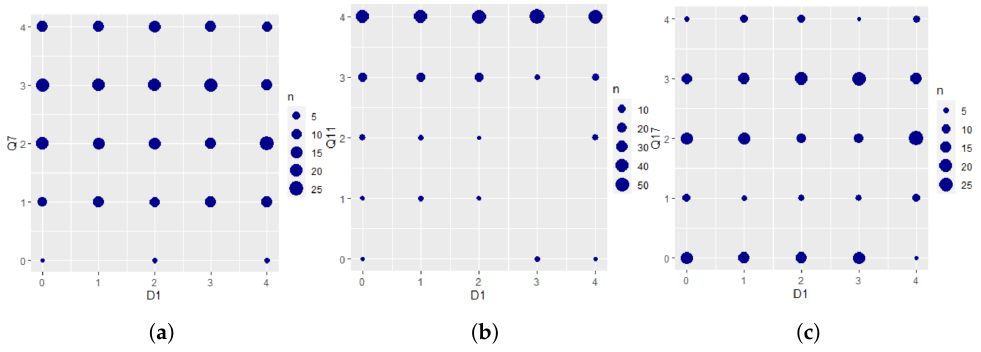
Figure 8. Scatter-plots between the Demographic data related to “D1: Age Category” and the three selected questions—Q7, Q11 and Q17 (Section 2.2). ( a ) Scatter-plot between D1 and Q7; ( b ) Scatter- plot between D1 and Q11; ( c ) Scatter-plot between D1 and Q17.